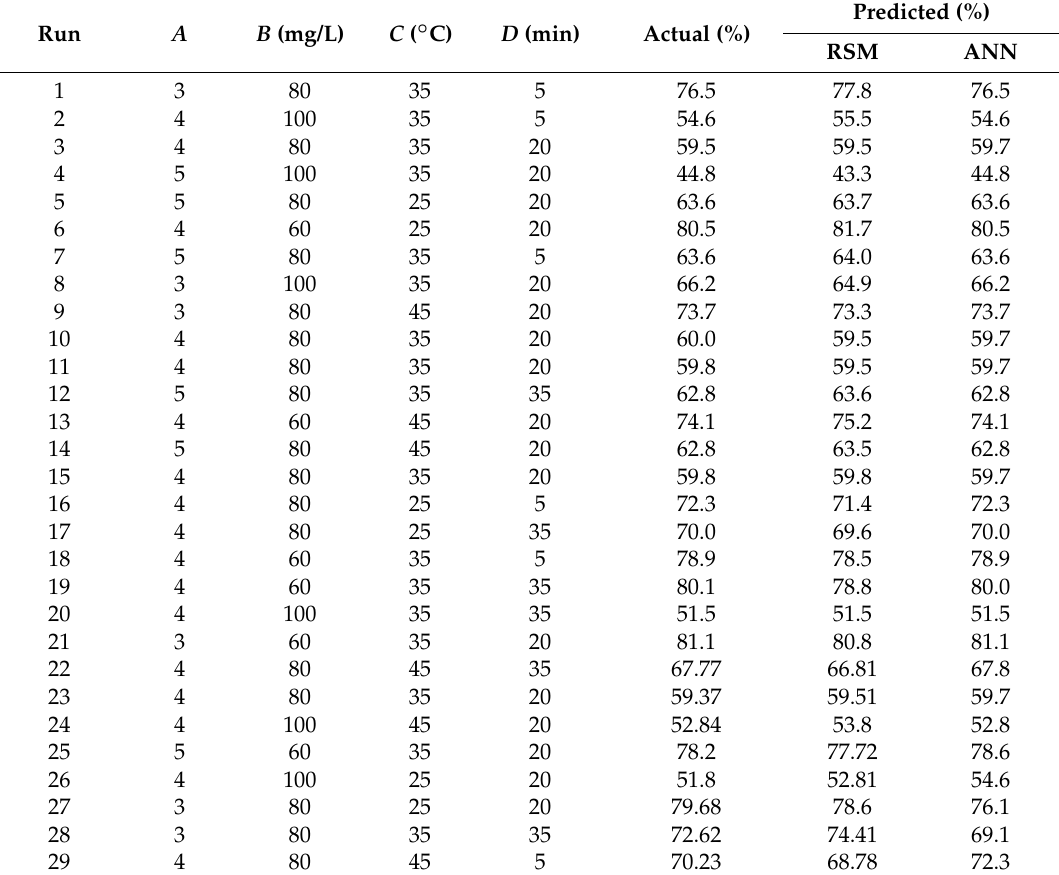
Figure 9. The relationship between the predicted and actual values for the Box-Behnken design (BBD). Table 2. Experimental and predicted values of Rhodamine B (Rh B) removal (%).